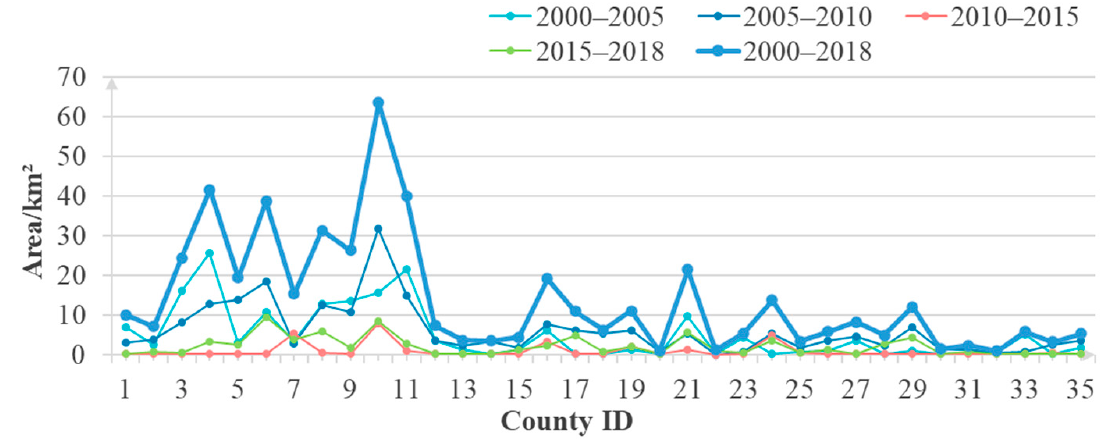
Figure 3. Variation of the cultivated land occupied by urban expansion in the study area from 2000 to 2018. Notes: 1–35 represents Jinjiang District, Qingyang District, Jinniu District, Wuhou District,